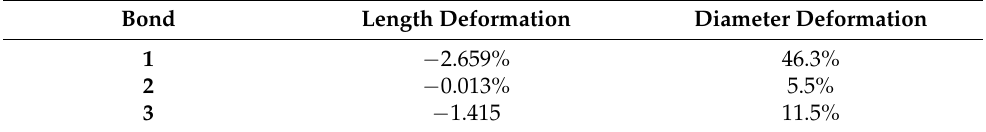
Table 2. Length and diameter deformation of bonds.